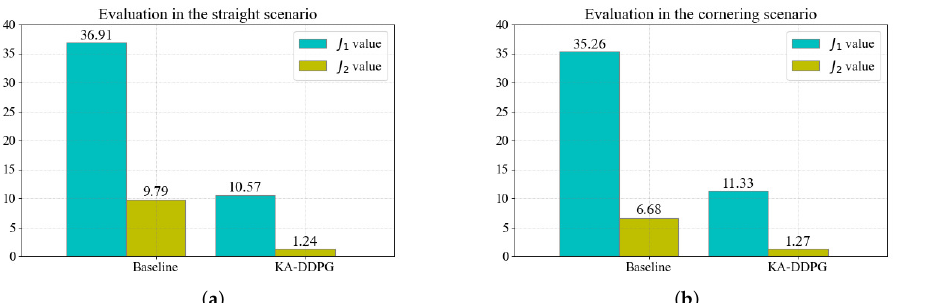
Figure 12. Quantitative evaluation results: ( a ) evaluation in the straight scenario and ( b ) evaluation in the cornering